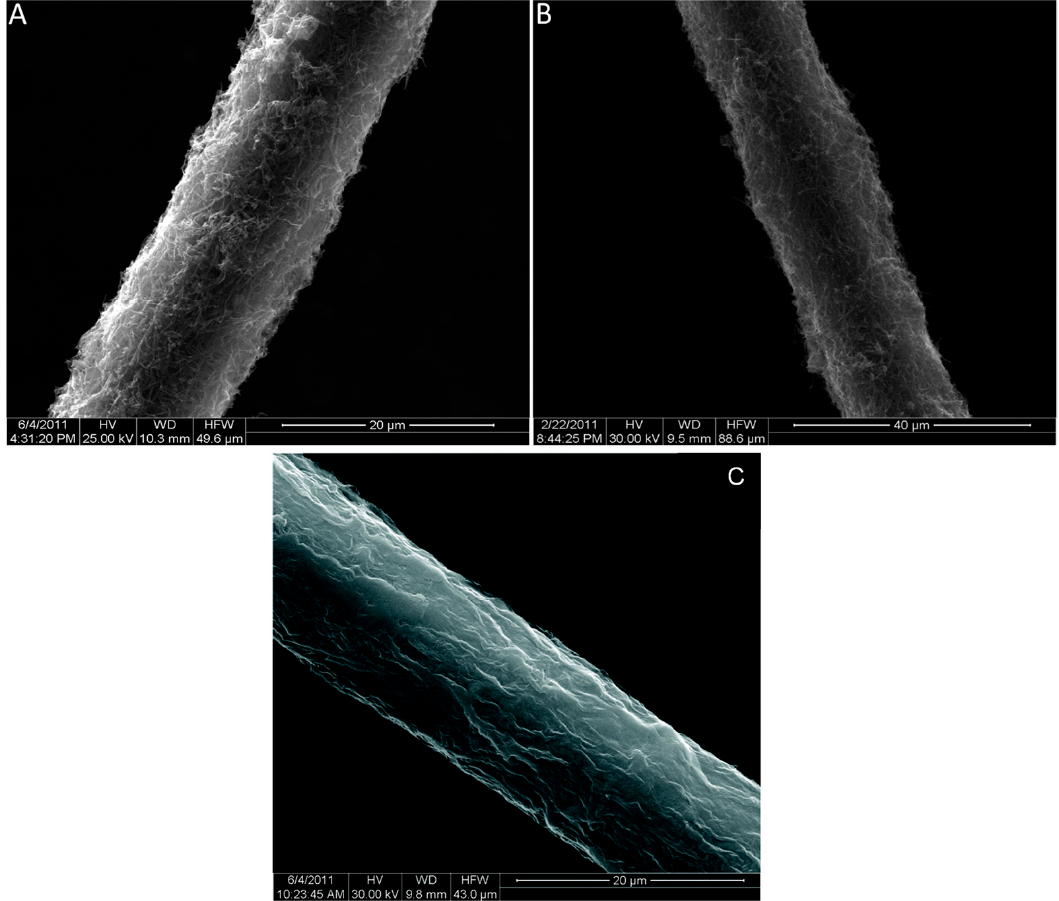
Figure 9. SEM images of ( A ) GNR-coated Kevlar fiber; the scale bar is 20 μ m, ( B ) A MWCNT-coated Kevlar fiber; the scale bar is 40 μ m; ( C ) SWCNT-coated Kevlar fiber, scale bar is 20 μ m. Adapted with permission from [116]. Copyright 2011 American Chemical Society.